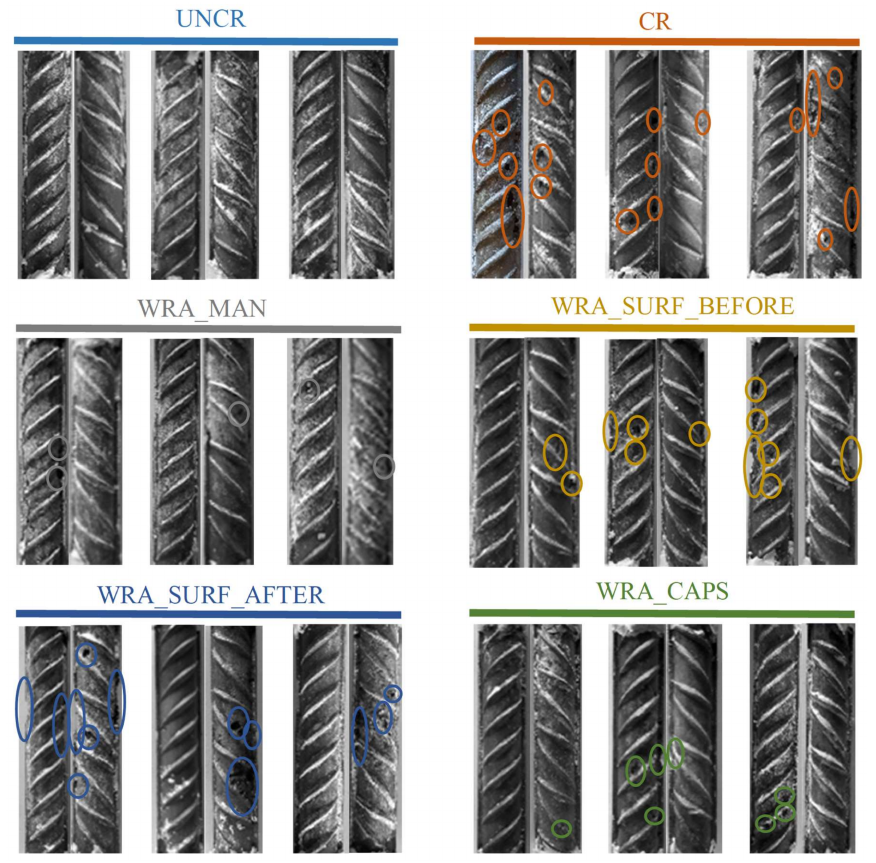
Figure 12. Photograph of each side of the anode after 135 cycles of chloride exposure (oval markings indicate the positions of the